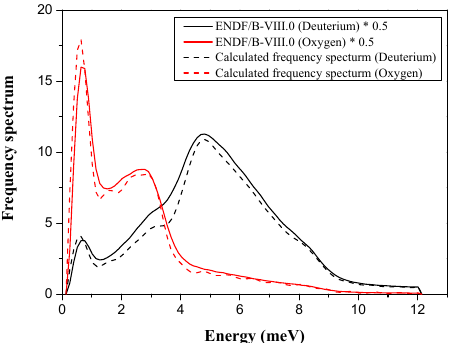
Fig. 2. Comparison of continuous spectra for deuterium and oxygen between the data used in ENDF/B-VIII.0 and calculated by GROMACS code (293.6